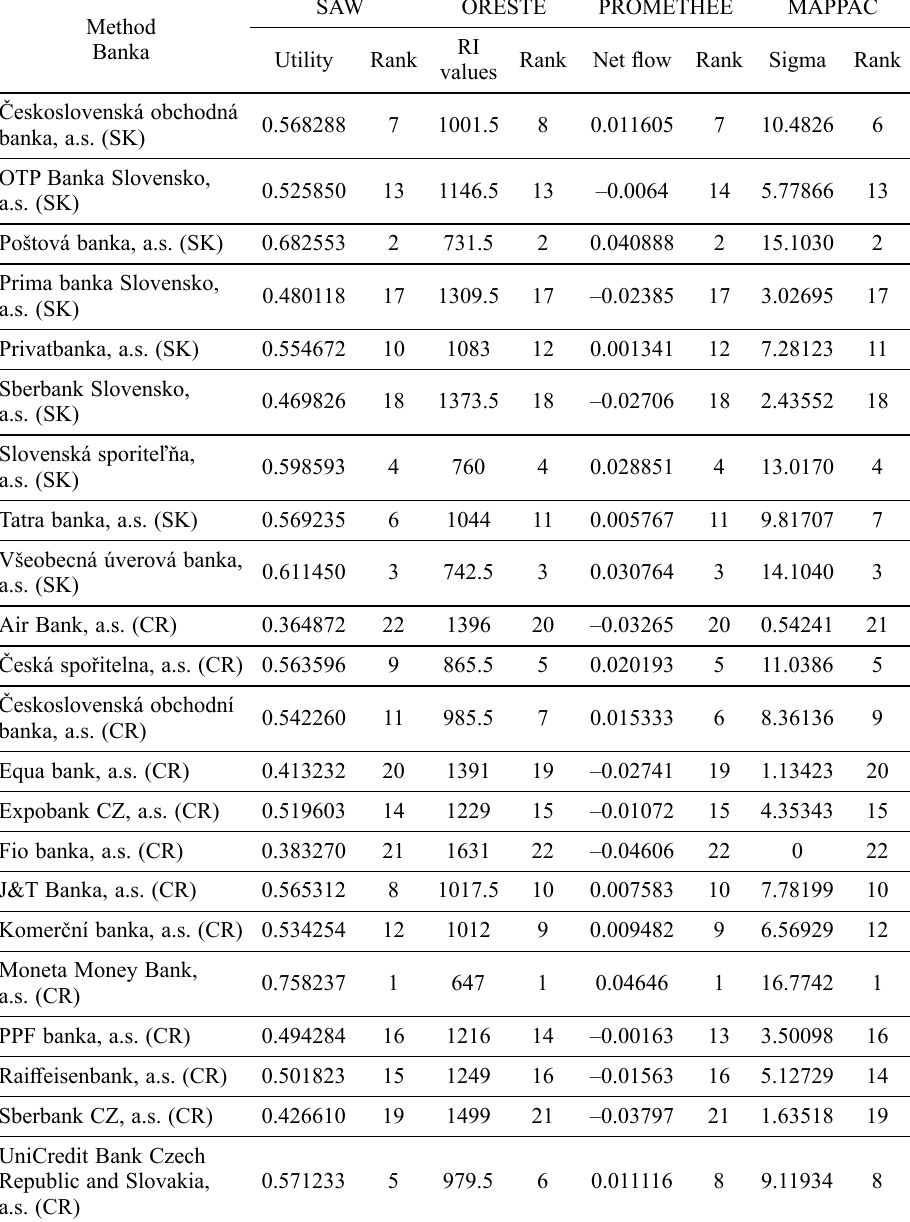
Table 4. Banking ranking based on multi-criteria assessment methods